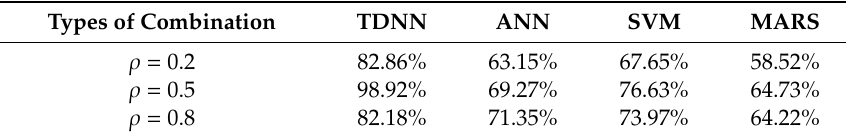
Table 10. The average AIRs of the four classifiers for an MNP 5 .